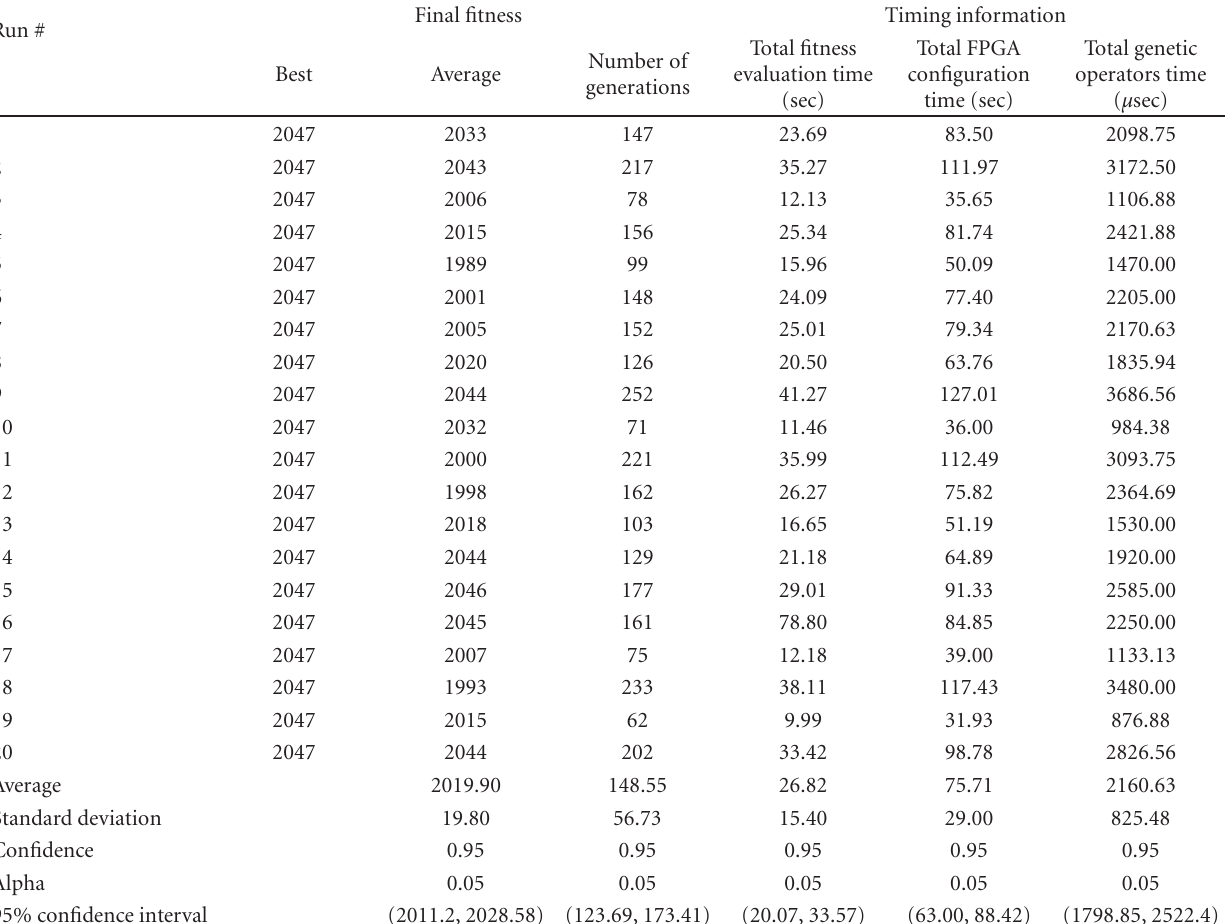
Table 6: Fitness and timing information for 20GA runs.